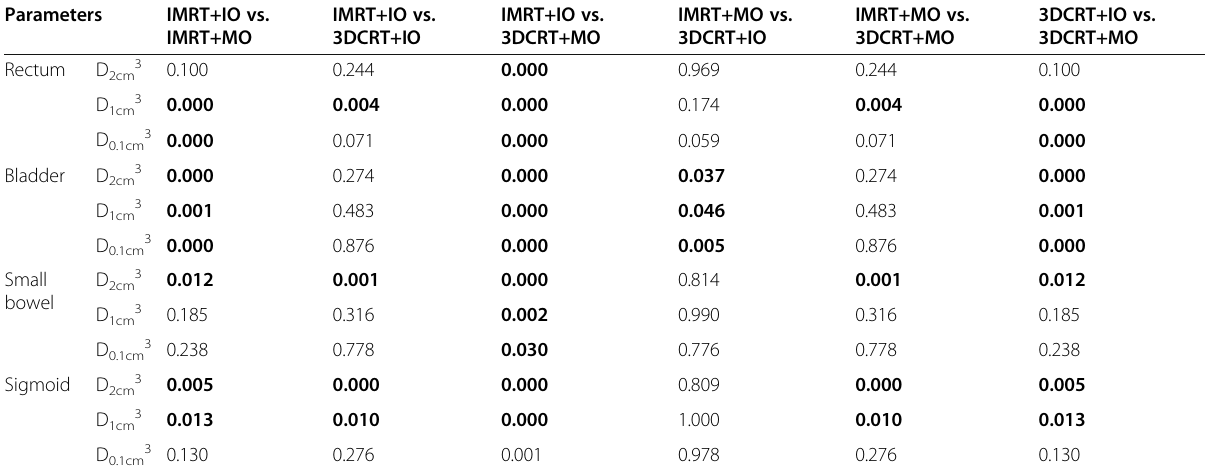
Table 4 Comparison of statistical significance for OARs